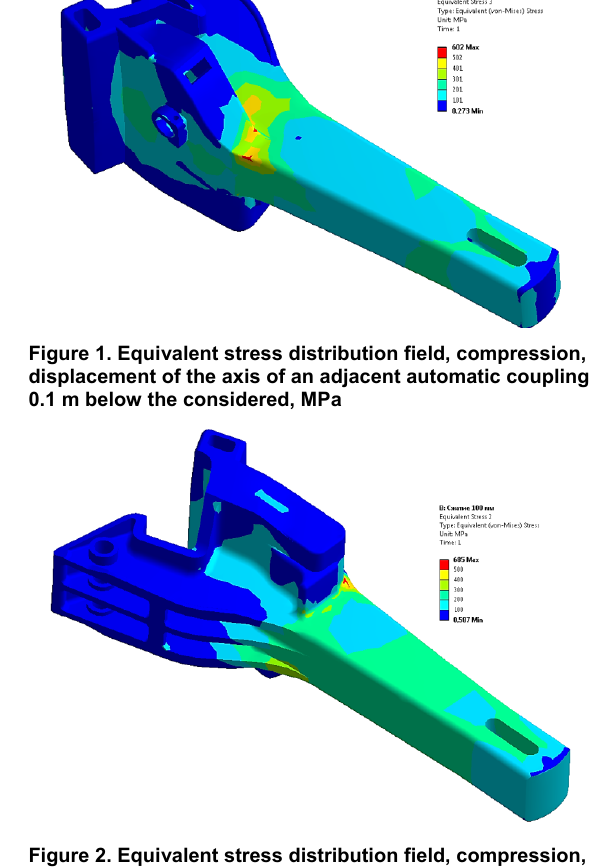
Figure 2. Equivalent stress distribution field, compression, displacement of the axis of an adjacent automatic coupling 0.1 m higher than the considered,